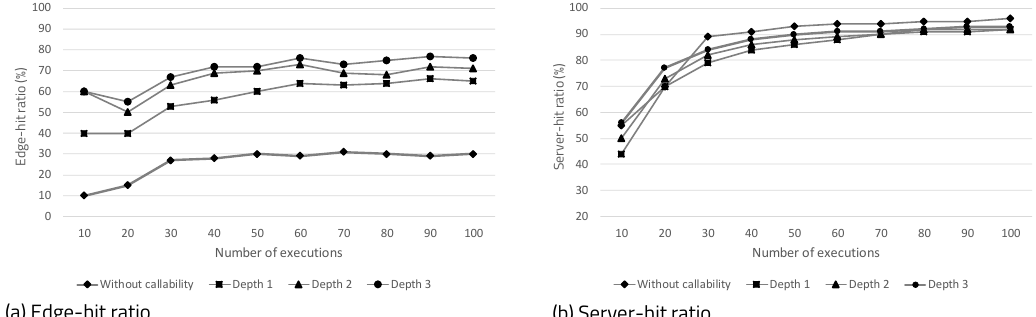
Figure 17. Hit ratio according to number of executions and observation